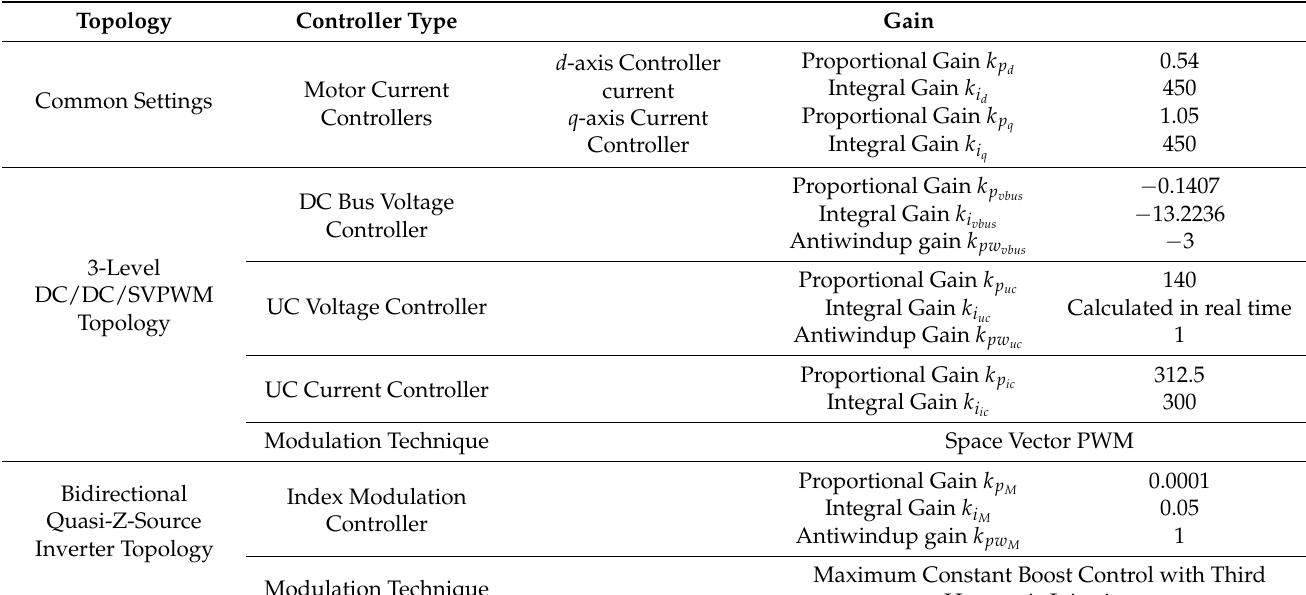
Table 5. Controllers settings and modulation